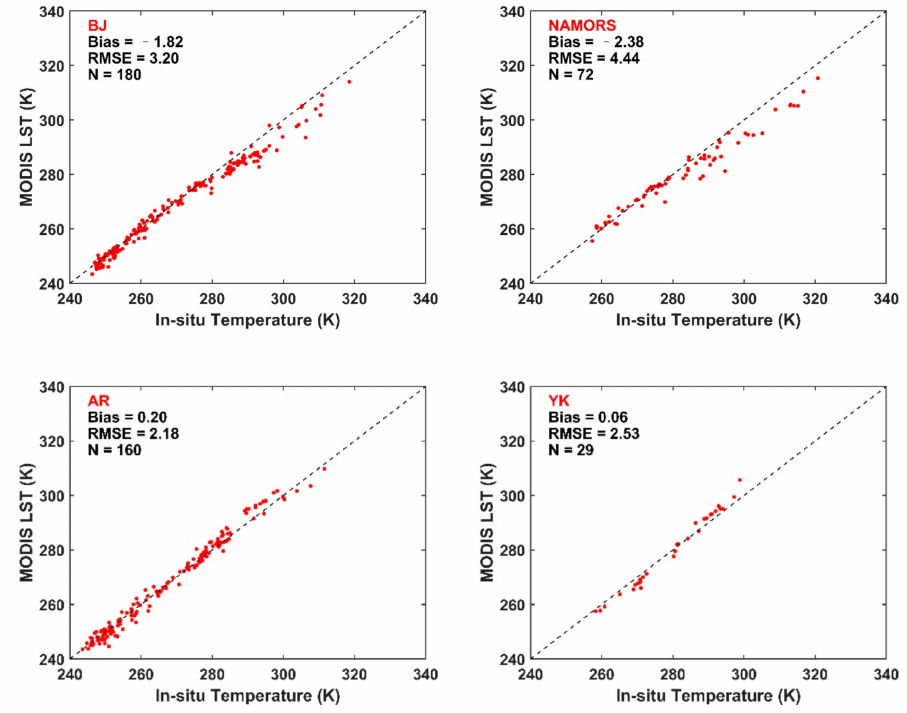
Figure 9. The scatter plots of the in situ temperature and MODIS LST at each site. The scatter plots of the in situ temperature and fused LST are provided in Figure 10. At the BJ, NAMORS, AR, and YK stations, the RMSE of clear-sky fused LST was 3.18 K, 4.50 K, 2.12 K, and 2.64 K, which was similar to the RMSE of MODIS LST, indicating similar accuracy of the clear-sky fused LST and MODIS LST. The RMSE of cloudy-sky fused